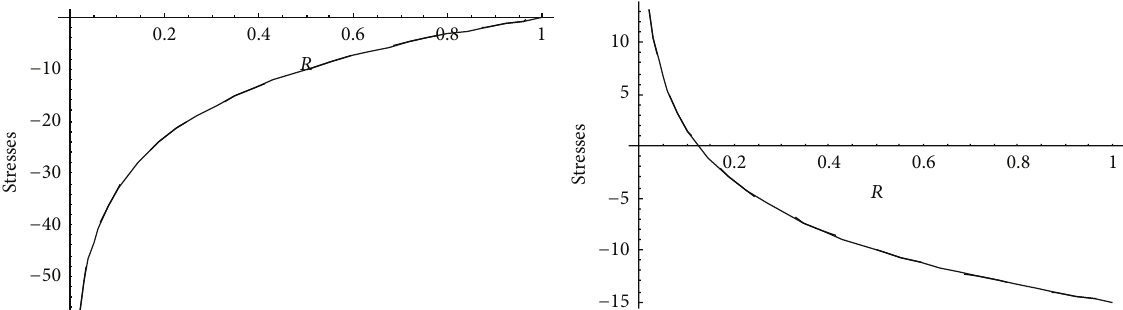
Figure 15: Homogeneous fully plastic stresses for a thick-walled circular cylinder under internal ( 𝑃 1 = 10 ) and external pressure ( 𝑃 2 = 0 and 15).